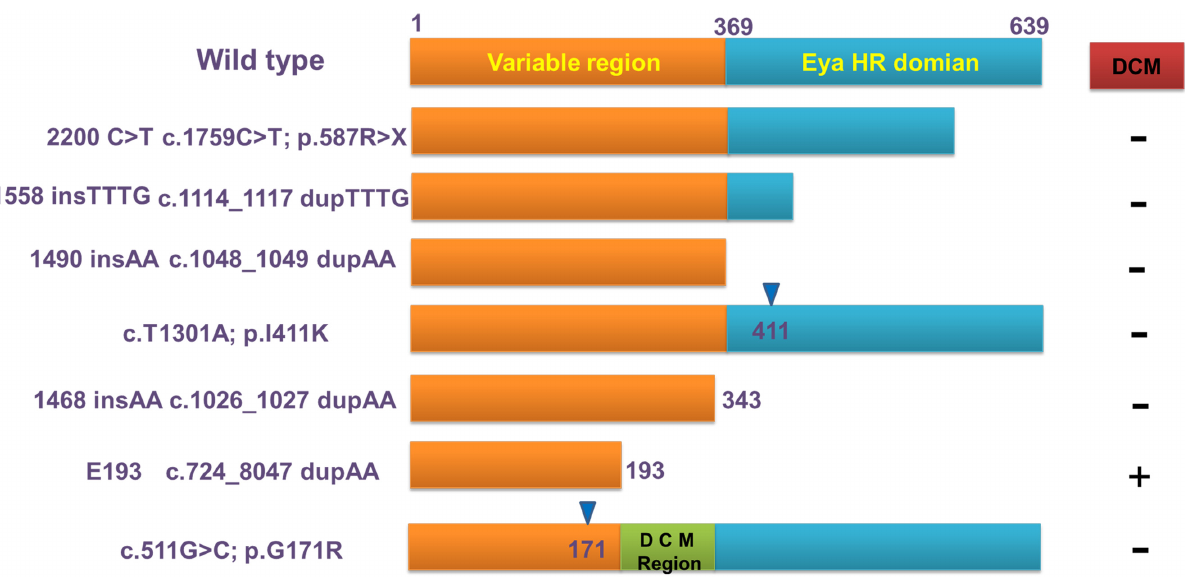
Fig 5. The effects of known EYA4 mutations on the EYA4 protein structure and on the cardiac phenotype. The number of amino acids of each allele product is indicated. Mutations that truncate the C-terminal Eya domain are associated with DFNA10 hearing loss and with a normal cardiac phenotype, whereas E193 truncates the N-terminal variable region and results in hearing loss plus dilated cardiomyopathy. Asp171 is in the variable region domain, and patients with this mutation presented with hearing loss and a normal cardiac phenotype.